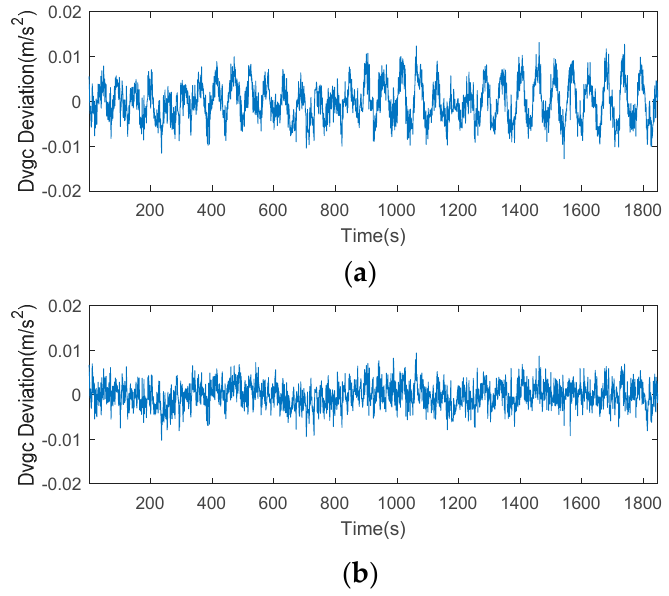
Figure 24. ( a ) CMCD (Time averaging, 100 epochs) in the time domain comparison before the adaptive frequency domain filter, G06, ( b ) CMCD (Time averaging, 100 epochs) in the time domain comparison after the adaptive frequency domain filter, G06.